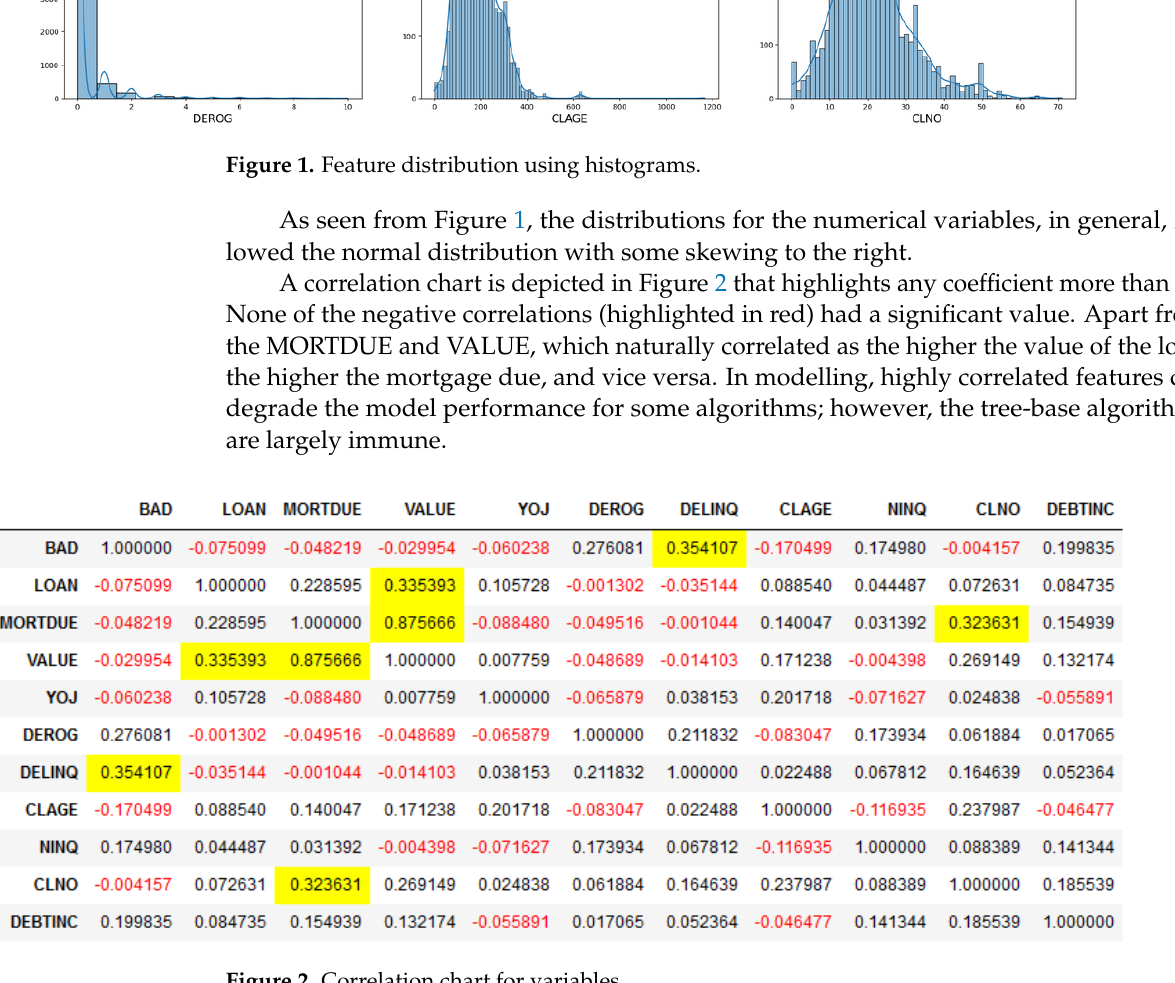
Figure 2. Correlation chart for variables.